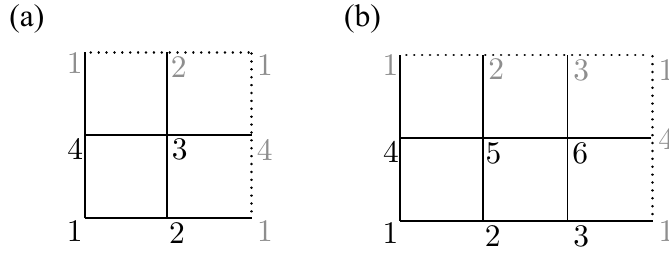
Figure 1 . (a) A four-qubit state and (b) A six-qubit state for the Wen-Plaquette model on a torus. The right dashed line is identi(cid:12)ed as the left solid line and the top dashed line is identi(cid:12)ed as the bottom solid line in (a) and (b). The numbers are the site indices. Each gray colored number is identi(cid:12)ed with the corresponding black colored